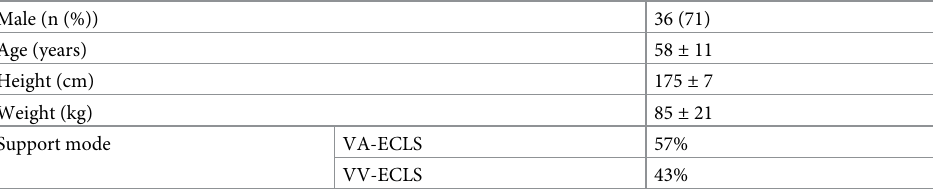
Table 1. Patient demographics.